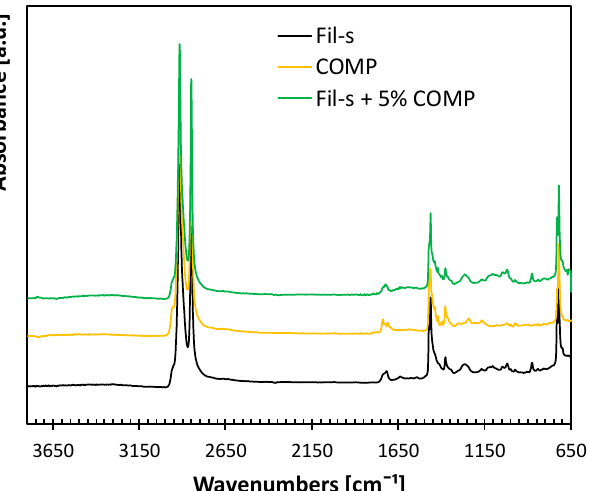
The FT-IR/ATR spectra of the neat Fil-s, the compatibilizer and their blend at 5 wt% of COMP are compared in Figure 3.